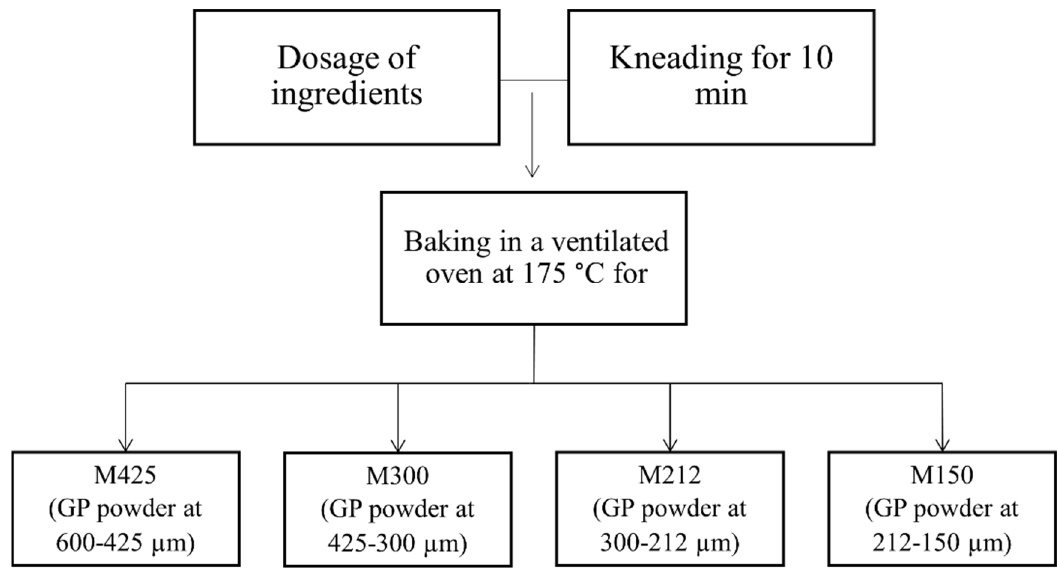
Figure 1. Muffin production process. GP: grape pomace .